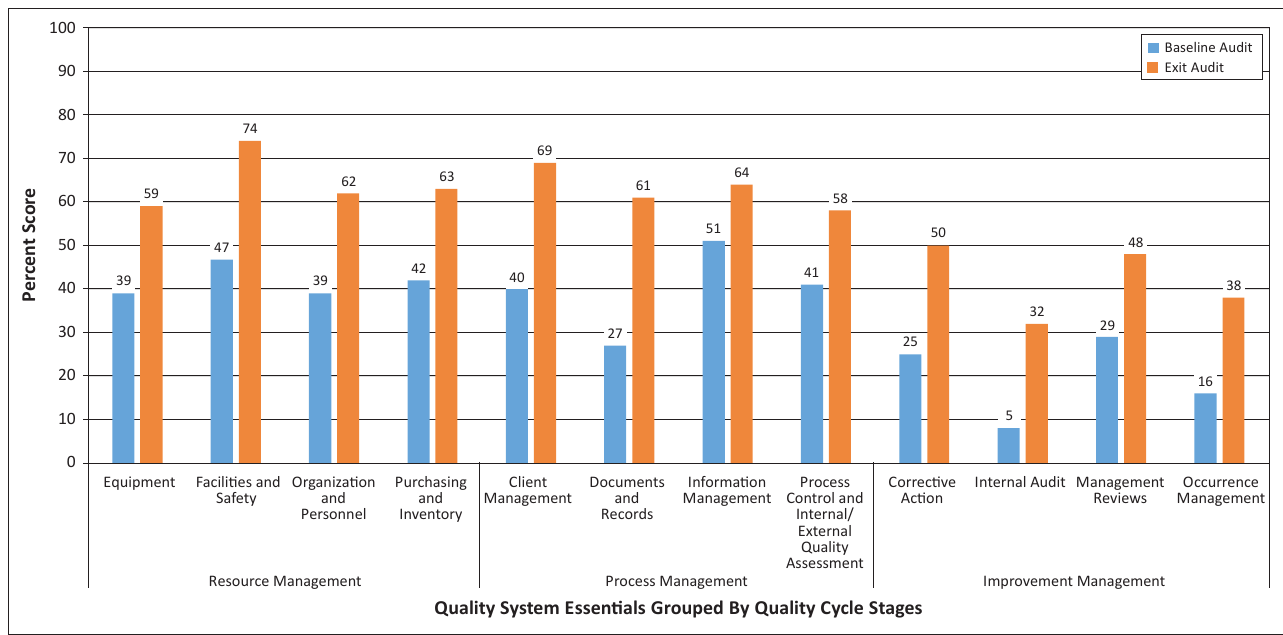
FIGURE 1: Baseline and exit audit scores for Quality System Essentials grouped by quality cycle stage from 126 laboratories in 12